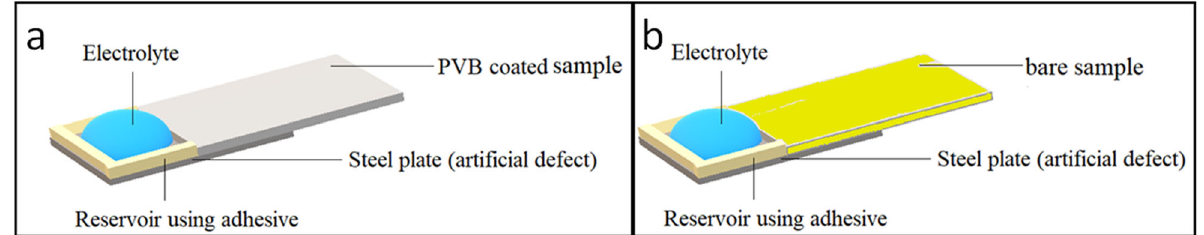
Fig. 13 Sample model. Model of sample used to study a Cathodic delamination with phenolphthalein incorporated in PVB and b in situ cathodic electrolyte spreading with Scanning Kelvin